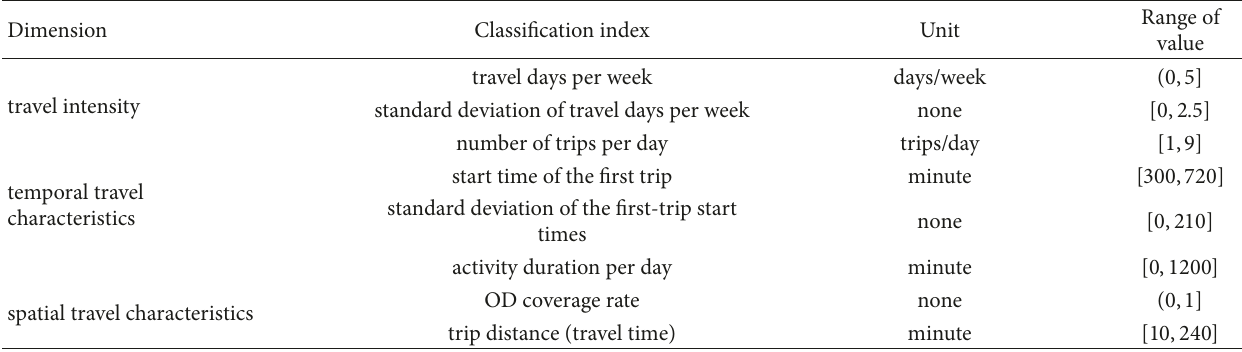
Table 5: Summary of classification